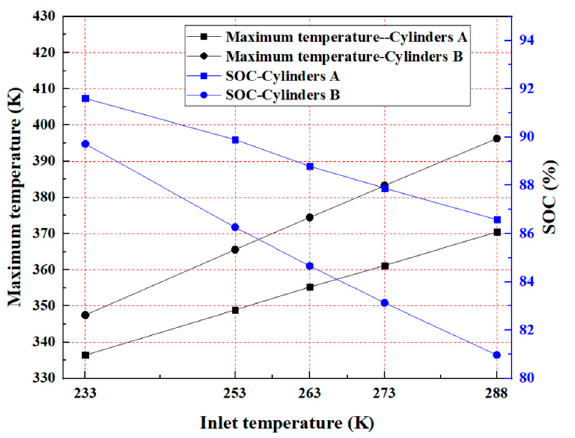
Figure 15. Relationships for the maximum hydrogen temperature and SOC with the inlet temperature at the end of filling.